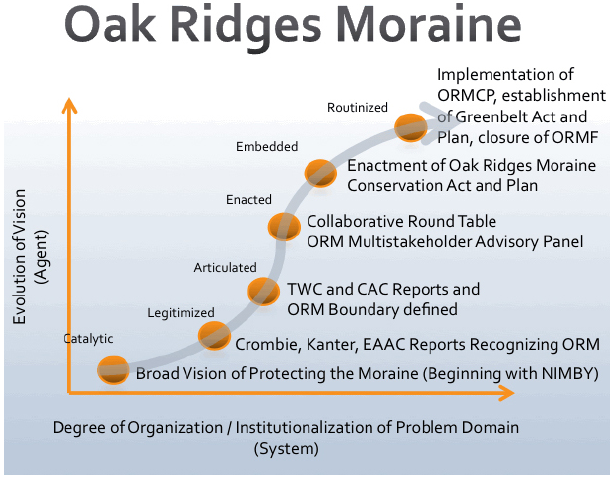
Fig. 3 . The vision as social construction heuristic applied to the Oak Ridges Moraine conservation